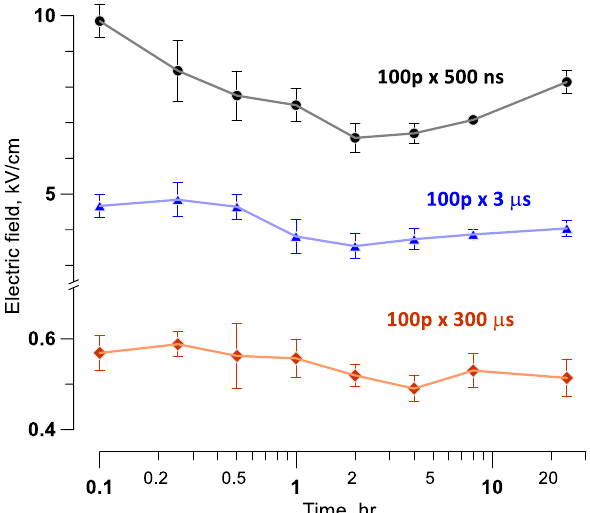
Figure 5. Electric field thresholds for cell death as measured at different time intervals after PEF exposure (100 pulses at 10 Hz; pulse duration is marked in the legends). The smallest thresholds were measured at 2 and 4 h after the exposure. See text for